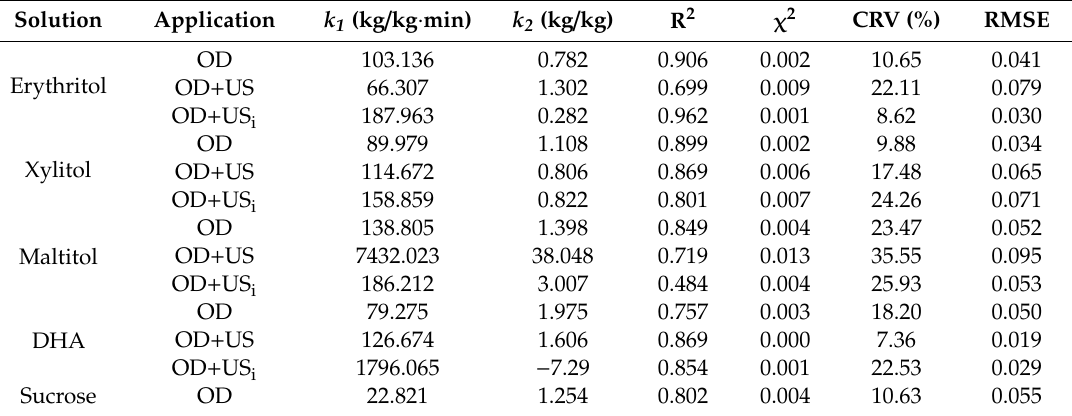
Table 6. Values of k 1 , k 2 , R 2 , χ 2 , CRV, and RMSE of modelling SG using Peleg’s